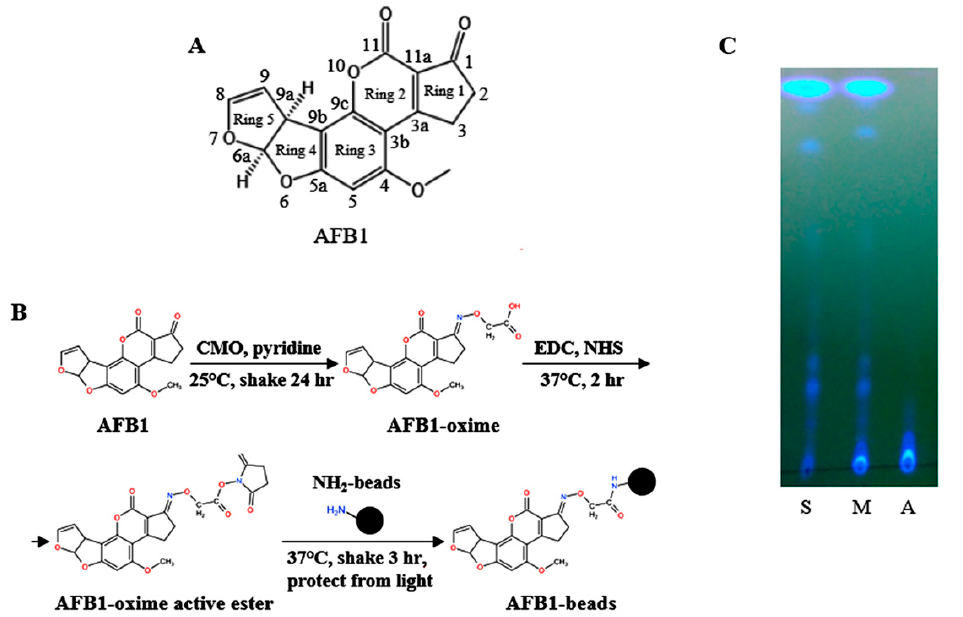
Figure 1. Preparation of the AFB1-MNPs. ( A ) Structure of AFB1. ( B ) Reaction of the preparation of AFB1-linked magnetic nanoparticles (MNPs). ( C ) Thin-layer chromatography analysis of the activated AFB1. S: AFB1 (5 µ L), A: activated AFB1 (5 µ L), M: AFB1 and activated AFB1 mixture (10 µ